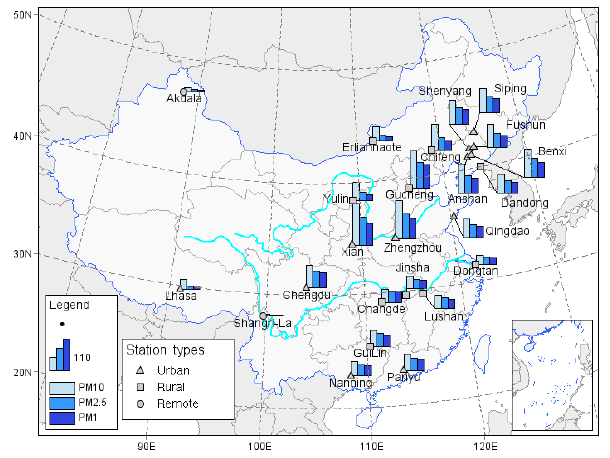
Figure 1. Map showing the PM observation stations and bar charts for their average PM 10 , PM 2 . 5 and PM 1 concentrations (µgm − 3